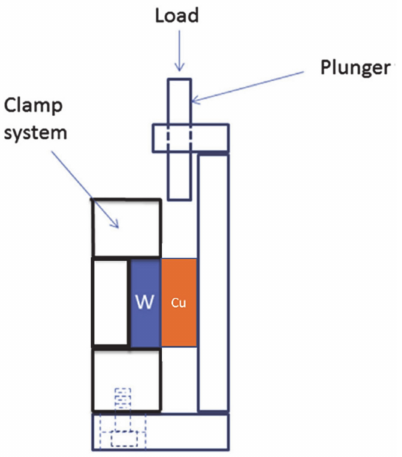
Figure 1. Shear fixture used for the mechanical tests.